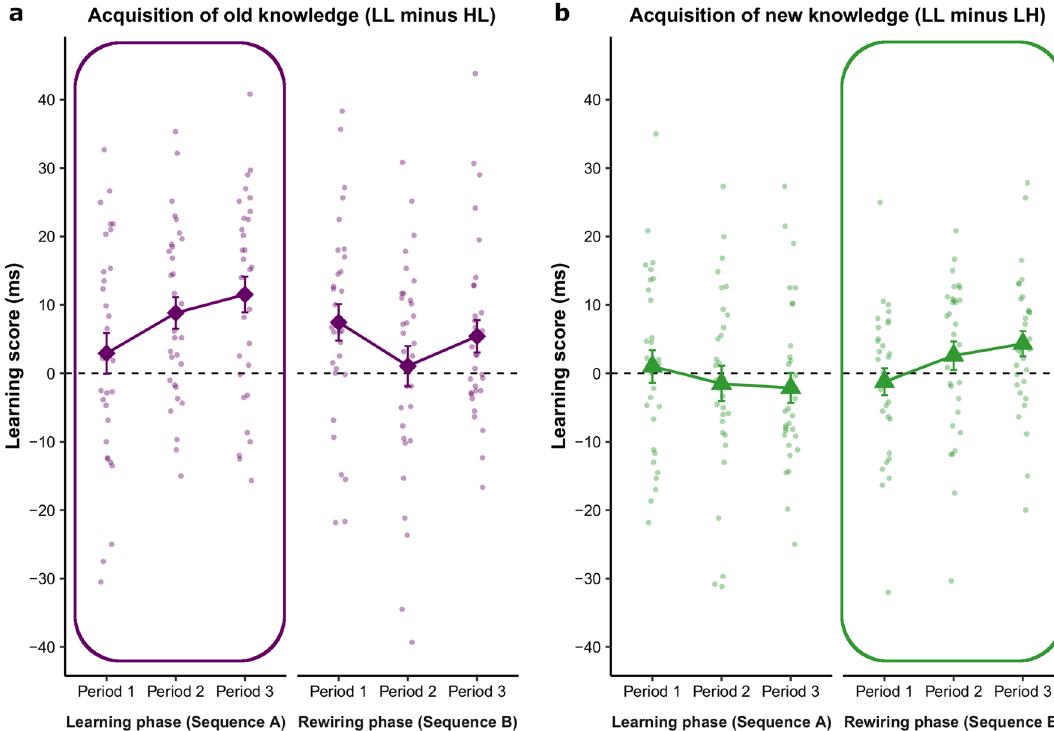
Figure 3. Learning trajectories of old and new knowledge in the learning and rewiring phases. The circled panels indicate the experimental phase in which higher learning scores were expected based on the probability of the trial types of comparison. For example, for the old knowledge (‘LL minus HL’ learning score), higher learning scores were expected in the Learning phase as trials with high vs. low triplet occurrence probability were contrasted here (‘LL minus HL’, underlined letters indicating probabilities of the current comparison; see also Fig. 2). ( a ) Participants successfully acquired the old knowledge (associations of Sequence A) in the Learning phase, indicated by gradually increasing learning scores. Then they at least partially unlearned this old knowledge in the Rewiring phase. ( b ) The new knowledge (associations of Sequence B) was gradually acquired in the Rewiring phase. (Since these associations were all low-probability in Sequence A, no learning was expected for them in the Learning phase). Please note that learning scores used in these analyses were calculated for Go trials only because no reaction times were collected for No-go trials in the Rewiring phase. Error bars represent Standard Error of the Mean